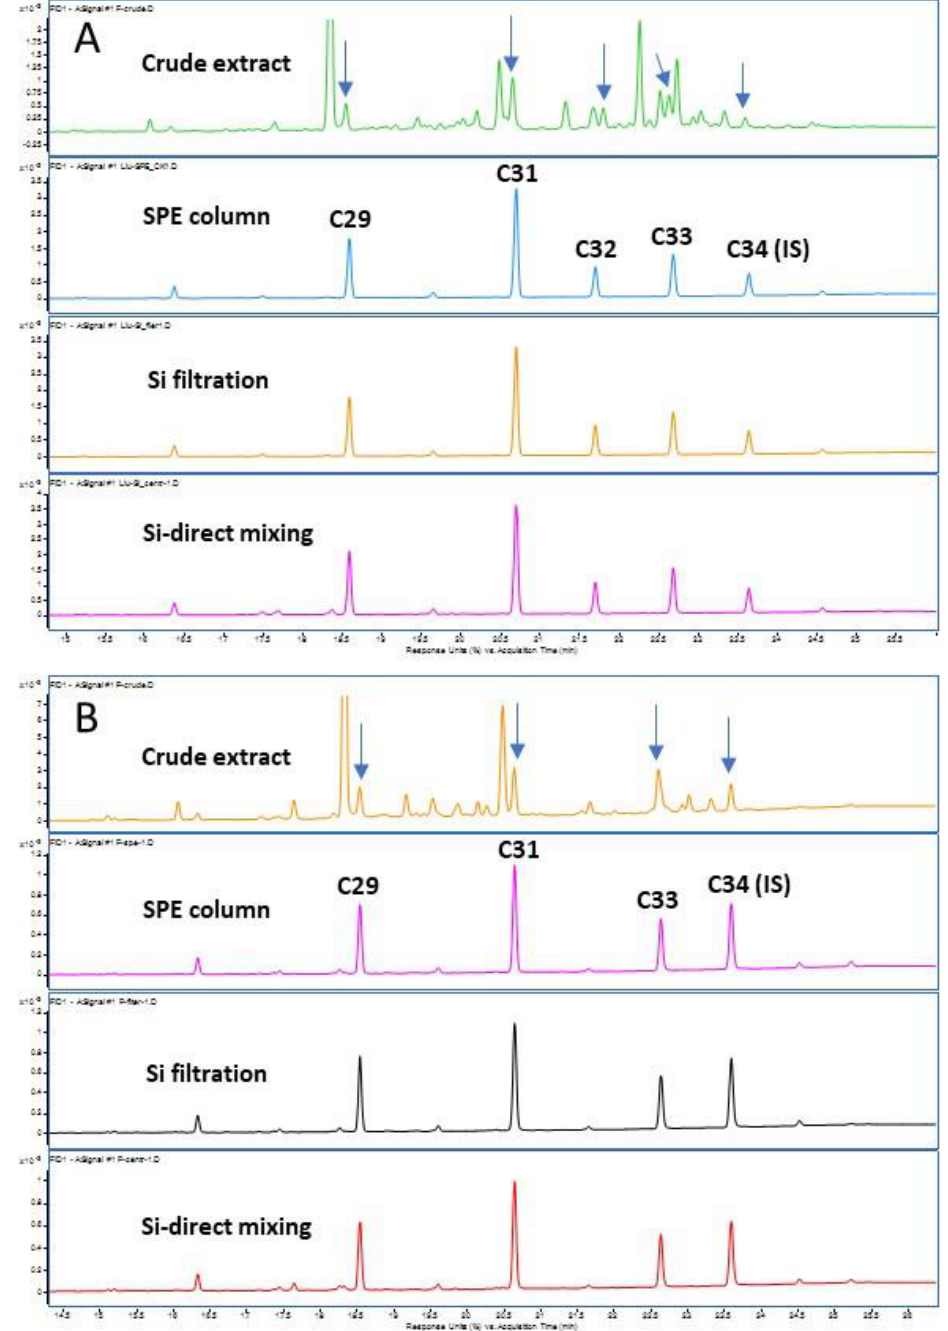
Figure 5. GC-FID profile of crude vs. purified extract. ( A ): faeces; ( B ): Figure 5. GC ‒ FID profile of crude vs. purified extract. ( A ): faeces; ( B ): herbage. Clearly, the filtration method requires an extra 5 mL syringe tube, but uses a smaller amount of silica powder (<500 mg). By comparison, the procedure of directly mixing the crude extract with silica powder is very simple to perform, but employing a sufficient amount of silica (no less than 1 g) and thorough mixing by vortex (for 2 min) is essential to achieve a satisfactory outcome. When these alternative sample cleaning methods are combined with the miniatur- ized saponification and liquid-liquid extraction steps, we estimate the sample processing throughput can be further increased by 25%.